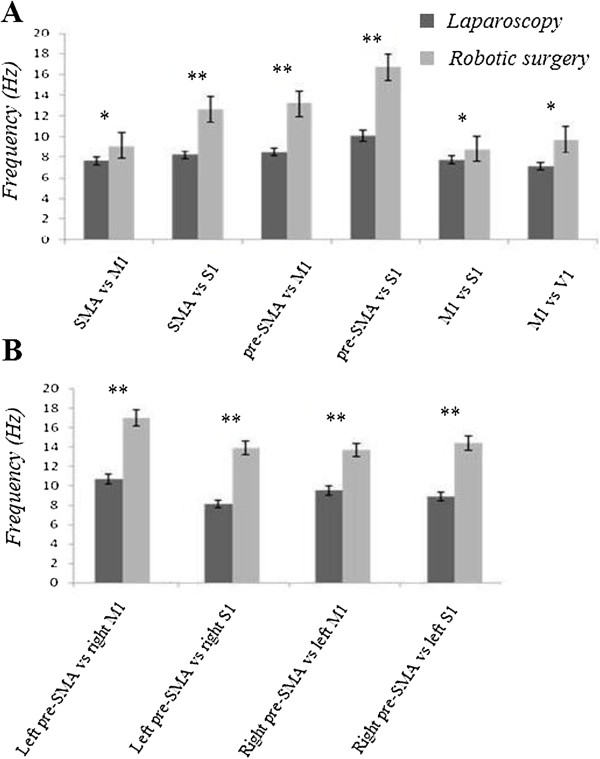
Mean EEG frequency values for all the considered recording locations, both for intra- (A) and inter-hemispheric (B) comparisons: note that when a robotic modality was used the beta and upper alpha frequencies were the more represented. Overall, the findings prove a different EEG driving between the two operating modalities in spectral frequency, as concerns intra- as well as inter-hemispheric analysis.